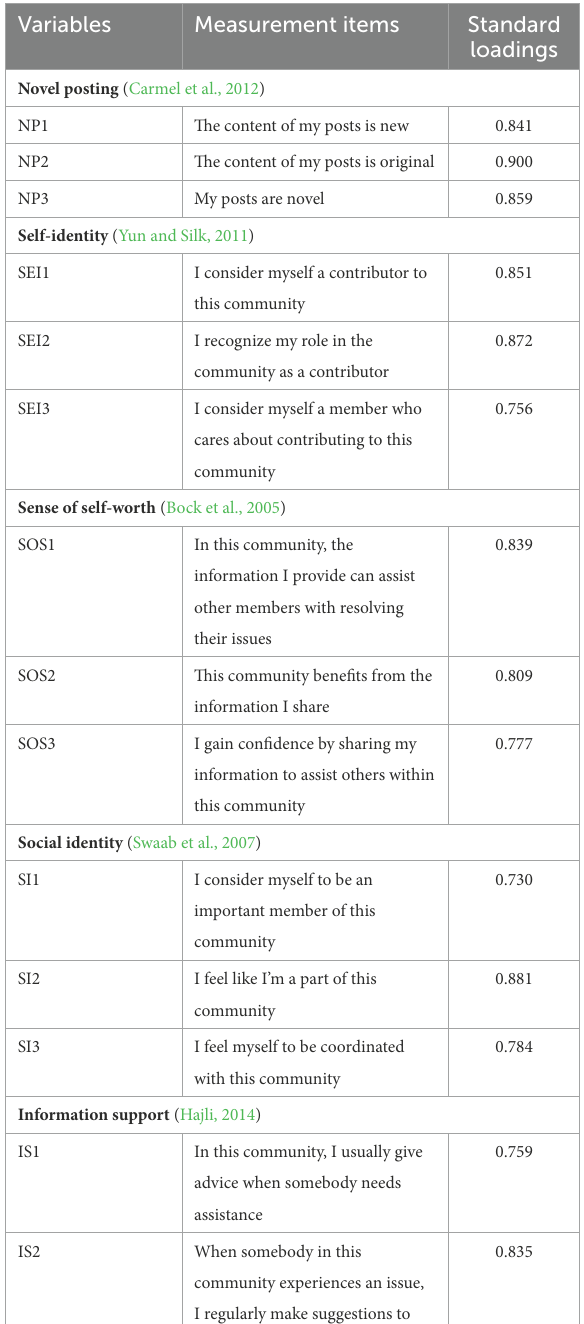
TABLE 3 Measurement items and standard loadings. TABLE 2 Cronbach’s alpha, composite reliability, and